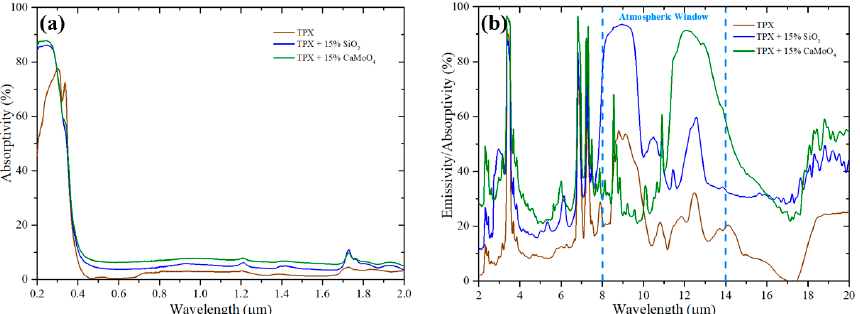
Figure 3. Measured emissivity/absorptivity spectra of the samples contained with a different functional nanoparticle. ( a ) Solar absorptivity of the samples. ( b ) IR emissivity/absorptivity of the samples. Table 1. Samples with different nanoparticle volume fraction and their corresponding theoretical cooling performance.